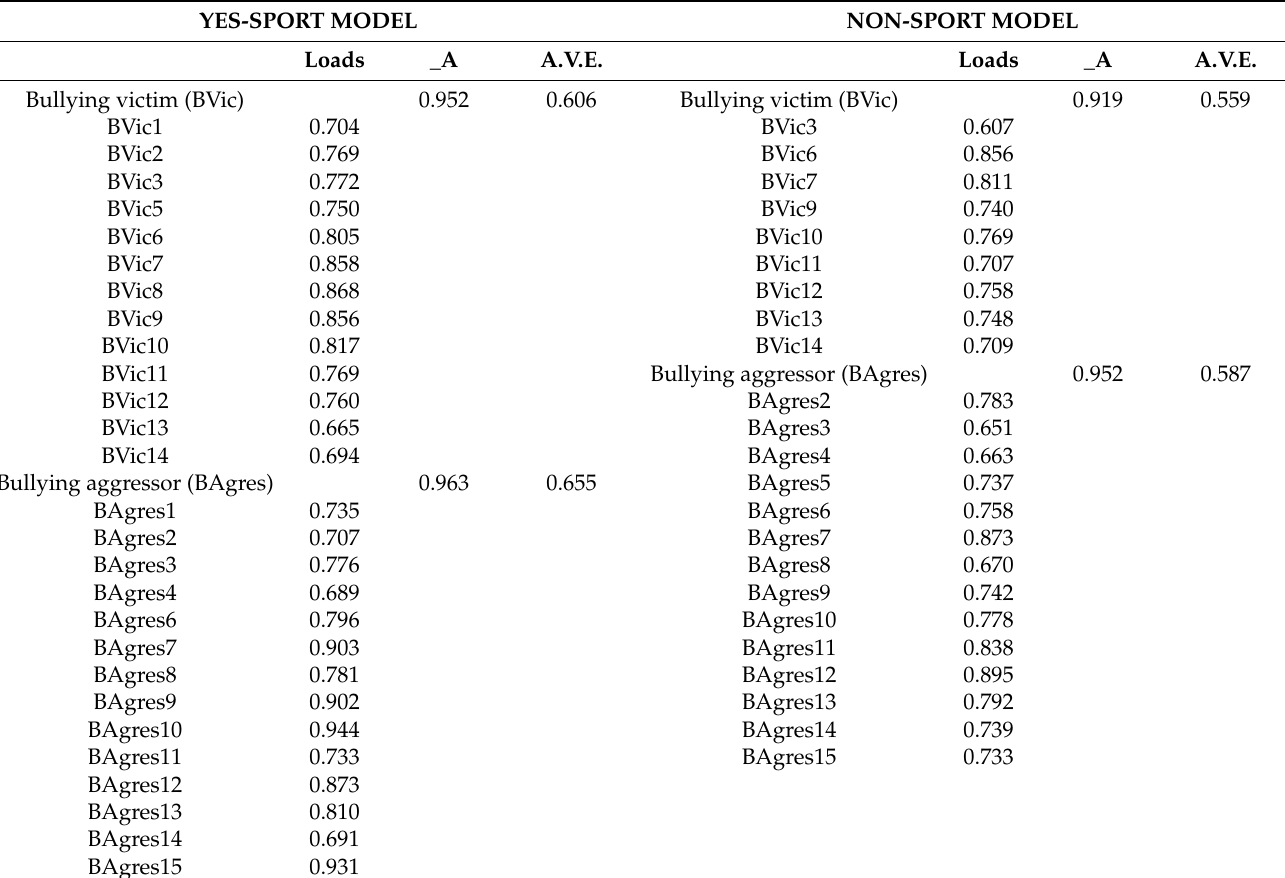
Table 5. Reliability and validity analysis of the measurement model (YES-SPORT Model).